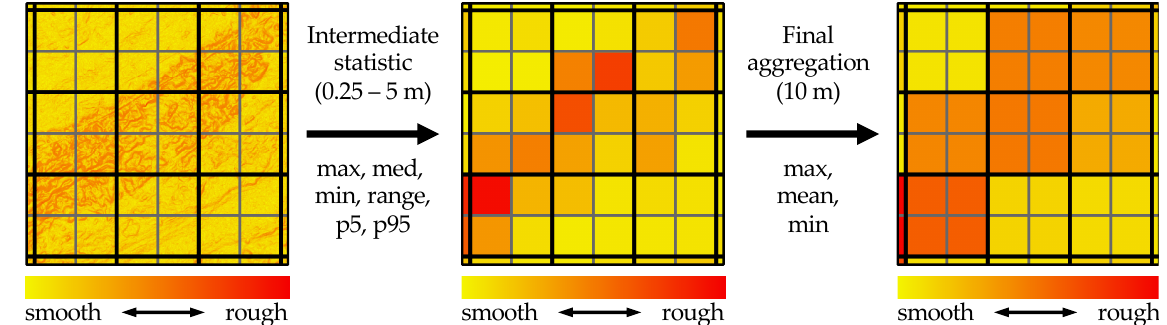
Figure 4. Example derivation of roughness metrics from raw surface roughness measurements. In this example, the ( left panel) shows the 0.03 m surface roughness measurements (yellow–red), a 5 m intermediate resampling grid (thick gray lines), and the 10 m Sentinel-1 pixels (thick black lines). The ( middle panel ) shows the roughness measurements resampled to the intermediate grid after taking the maximum roughness measurement inside each 5 m pixel. The ( right panel ) shows the final roughness metric at the 10 m resolution, calculated by taking the mean of the intermediate 5 m values inside each 10 m pixel.